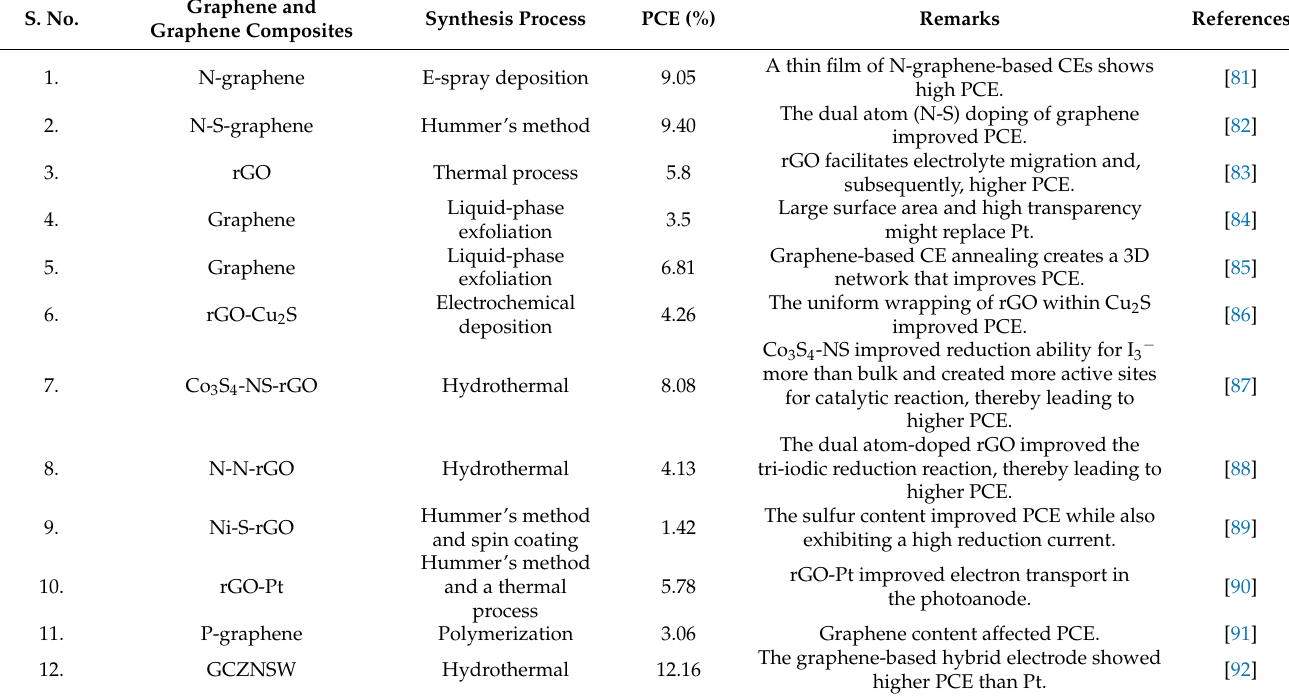
Table 1. Graphene and graphene composite-based